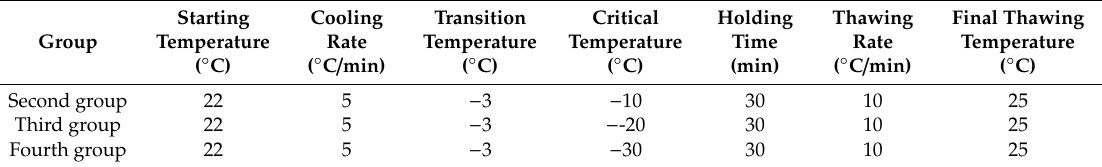
Table 4. Experimental scheme at di ff erent critical